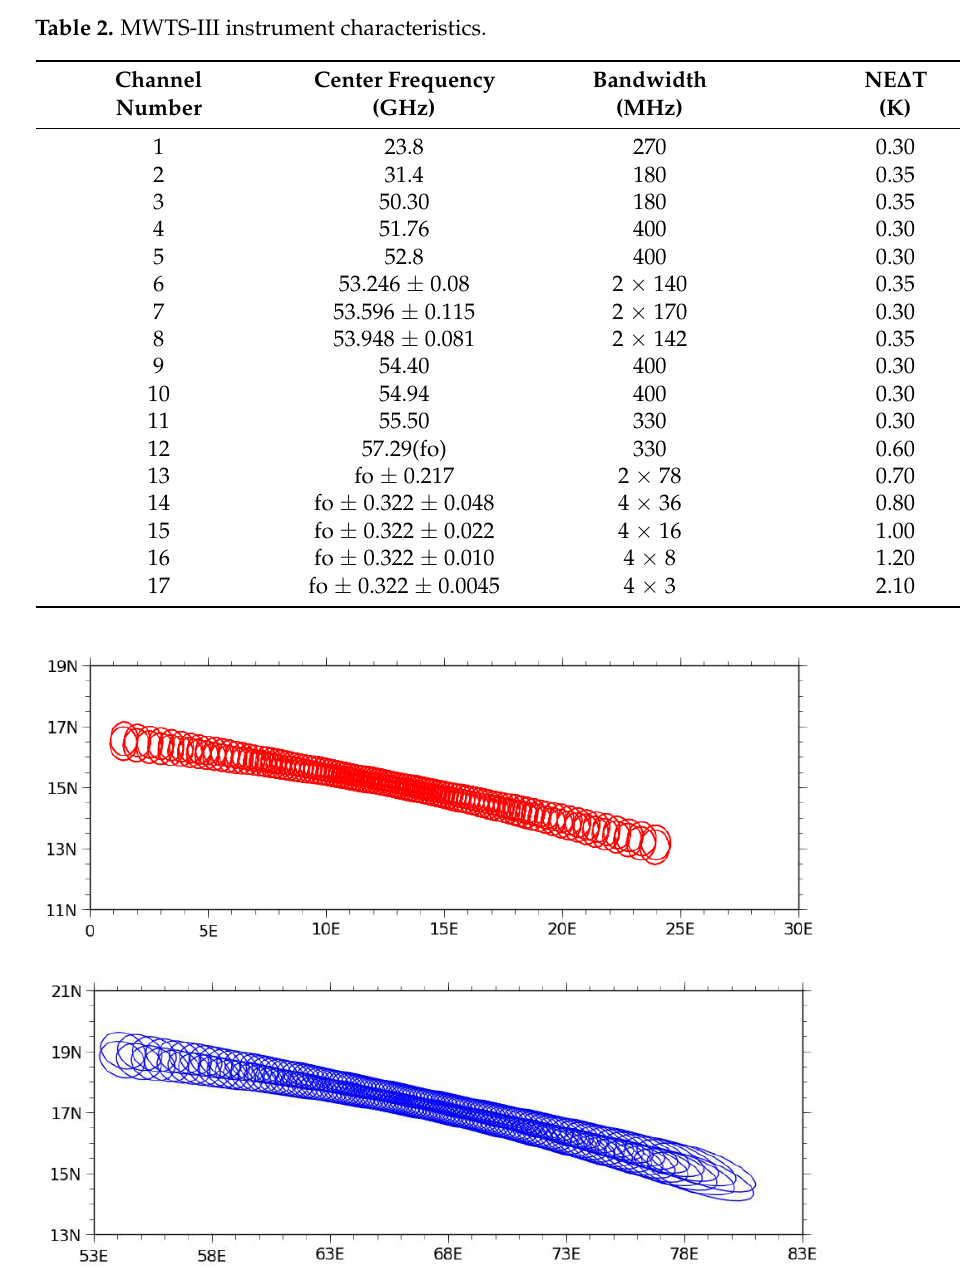
Figure 1. ATMS ( top ) and MWTS ( bottom ) field of view (FOV) dimensions for two adjacent scan lines with 5.2° beam width.